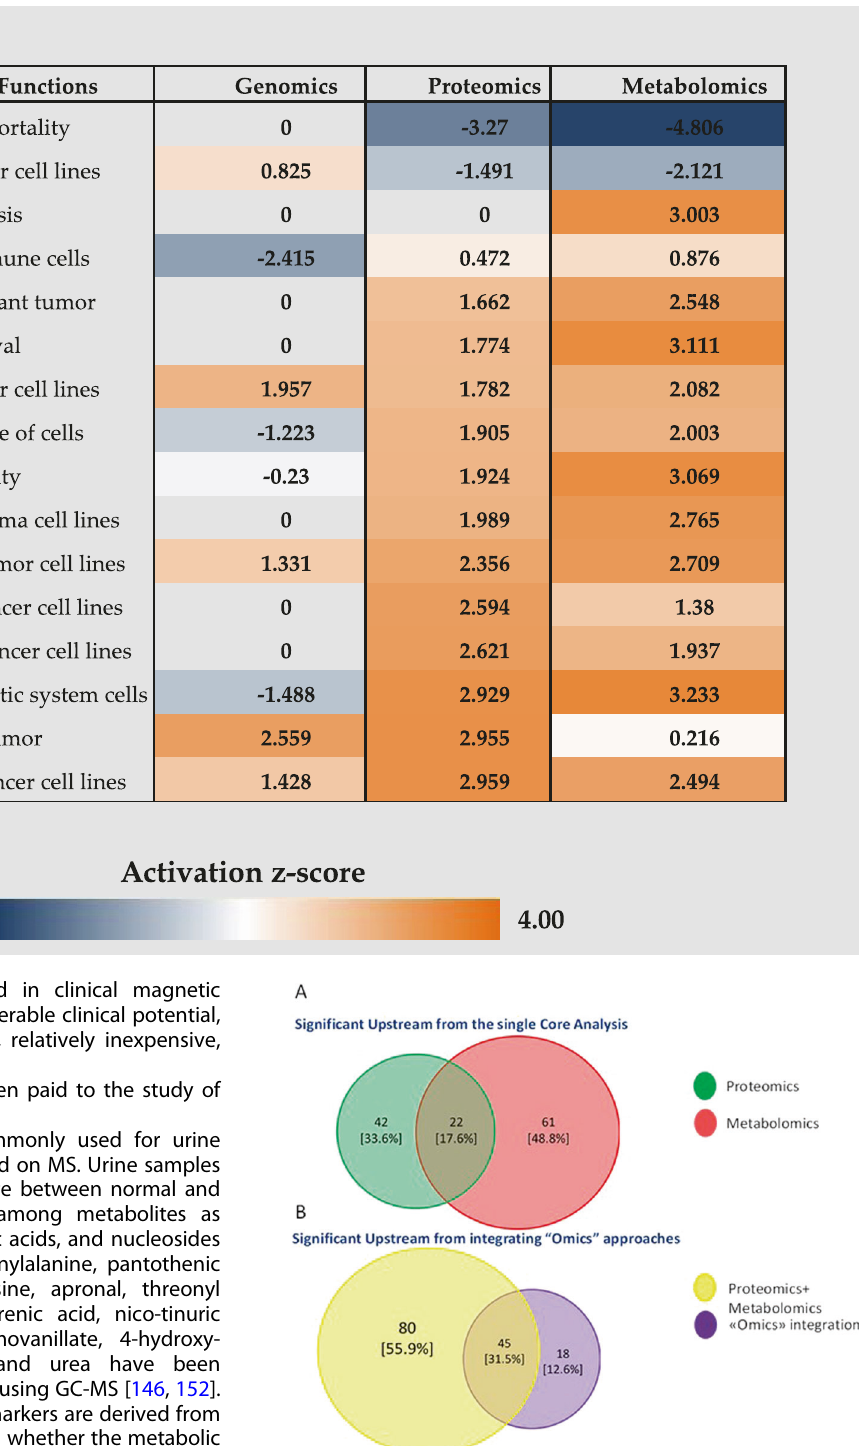
Table 1. Disease and biofunctions resulted from the meta-analysis on IPA tool for Genomics, Proteomics, and Metabolomics single data sets, respectively.